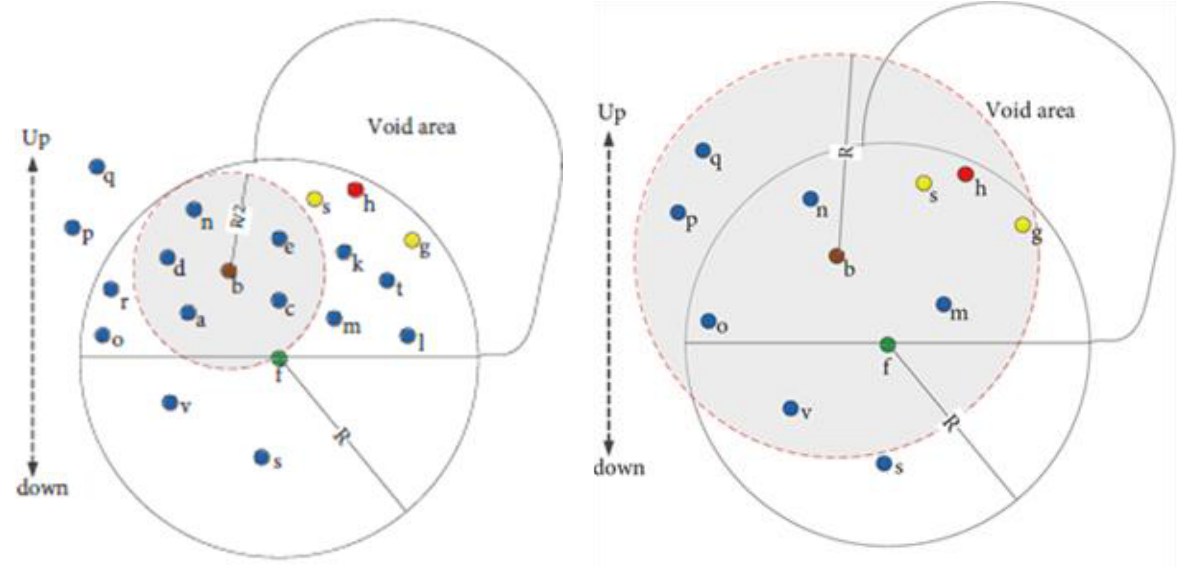
Figure 11. Resizing the forwarding area, sparse density on the right and dense density on the left